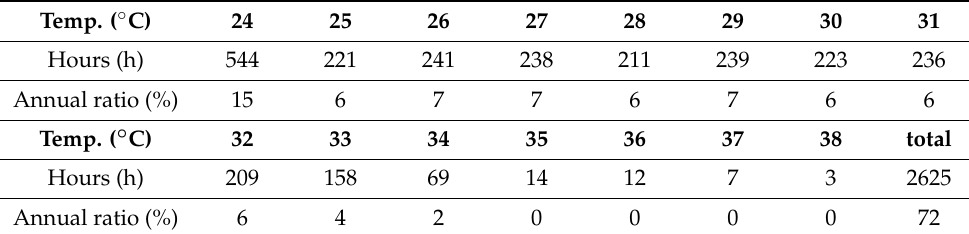
Table 1. Annual Statistics of External Temperature above 24 °C in Taipei. Table 1. Annual statistics of external temperature above 24 ◦ C in Taipei.